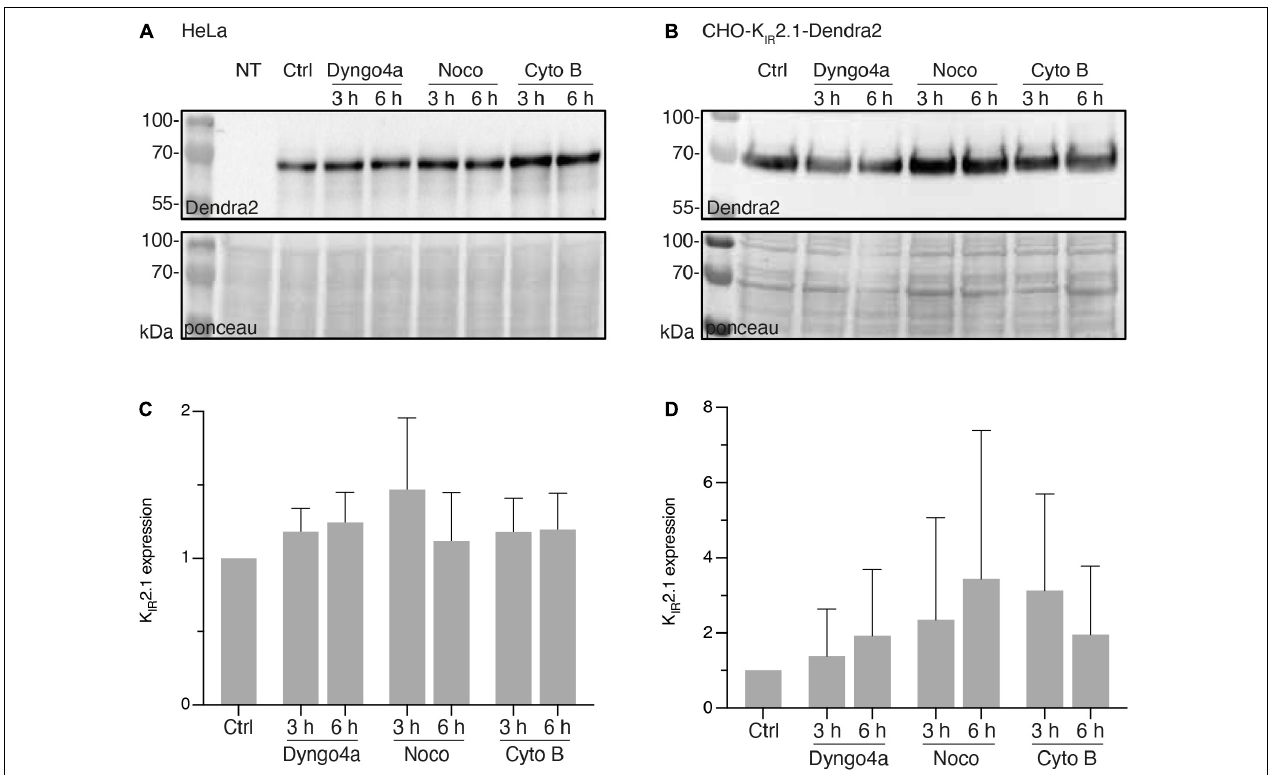
FIGURE 1 | Nocodazole, Cytochalasin B or Dyngo-4a treatment up to 6 h do not affect K IR 2.1-Dendra2 protein expression level. (A) Western blot analysis of K IR 2.1-Dendra2 expression in HeLa Cells treated for different time period with Dyngo-4a (10 nM), Nocodazole (30 µ M) or Cytochalasin B (20 µ M) ( n = 5). Non-transfected cells (NT) were used as negative control. (B) Western blot analysis of K IR 2.1-Dendra2 expression in CHO cells ( n = 6). (C) Summarized results of K IR 2.1-Dendra2 expression in control and HeLa cells treated for 3 h or 6 h ( n = 5). Data are presented as the fold of control. (D) Summarized results of (B) . Data are showed as mean ± SD, control protein level was designed as 100% after correction. Ponceau staining was used as a loading